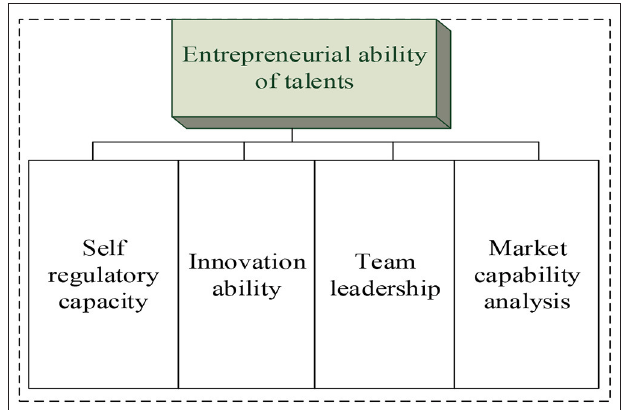
FIGURE 1 | The model of the entrepreneurial ability of new entrepreneurial